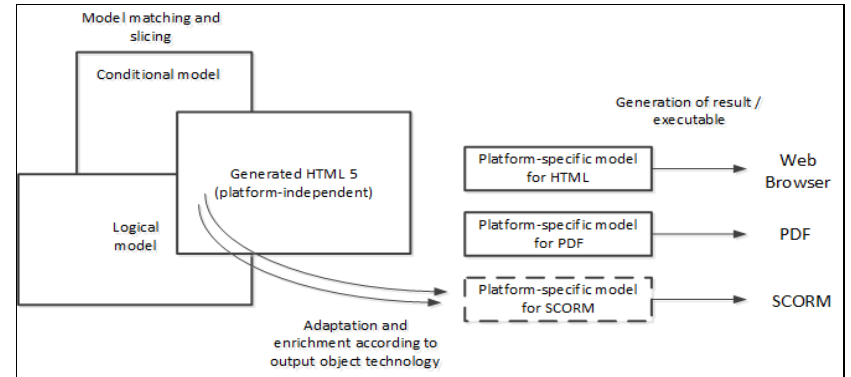
Fig. 1. The model matching and conversion process in the EMMA